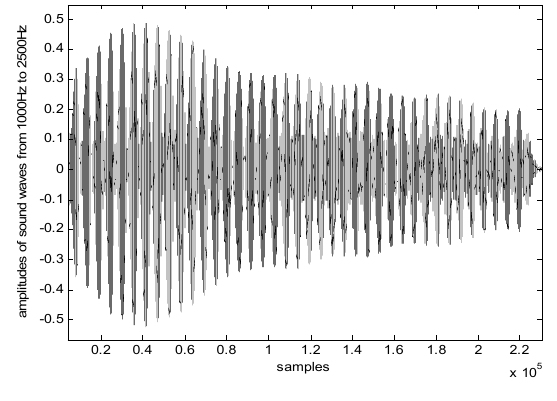
Figure 6. Waveform graph ( L = 4.6 m).